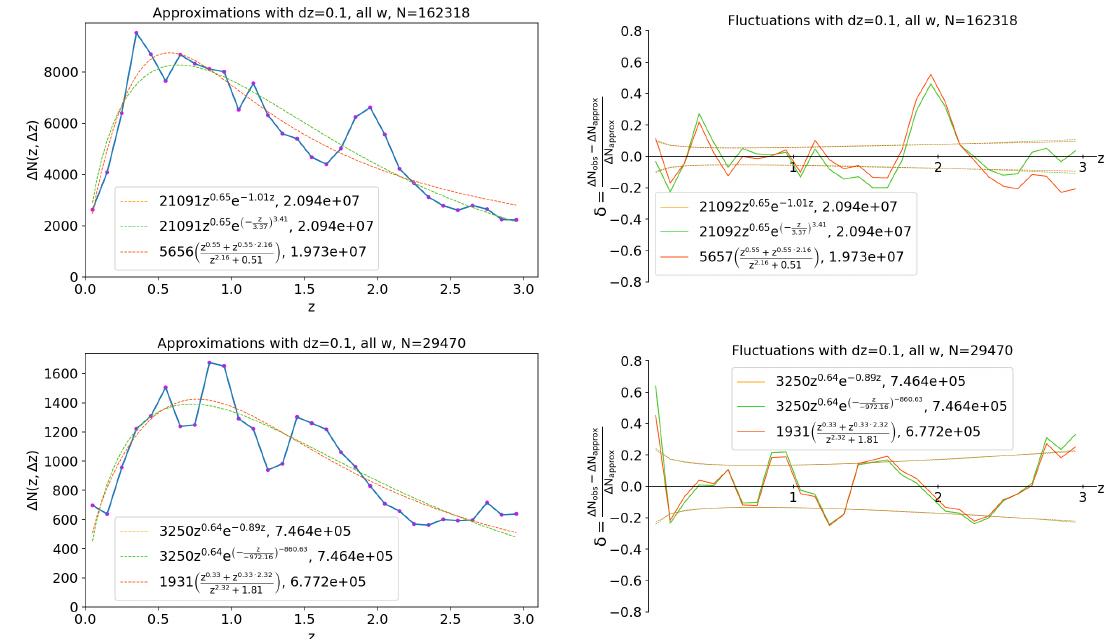
Figure A1. Histograms of the radial distribution of the COSMOS2015 photometric redshifts and corresponding fluctuation patterns for the disjoint 162,318 COSMOS galaxies ( top ) and 29,470 UltraVISTA galaxies ( bottom ) with a bin ∆ z = 0.1 and z max = 3 without sampling by σ ( z ) . The dashed lines indicate the least squares fit ( left ) and Poisson noise 5 σ ( right